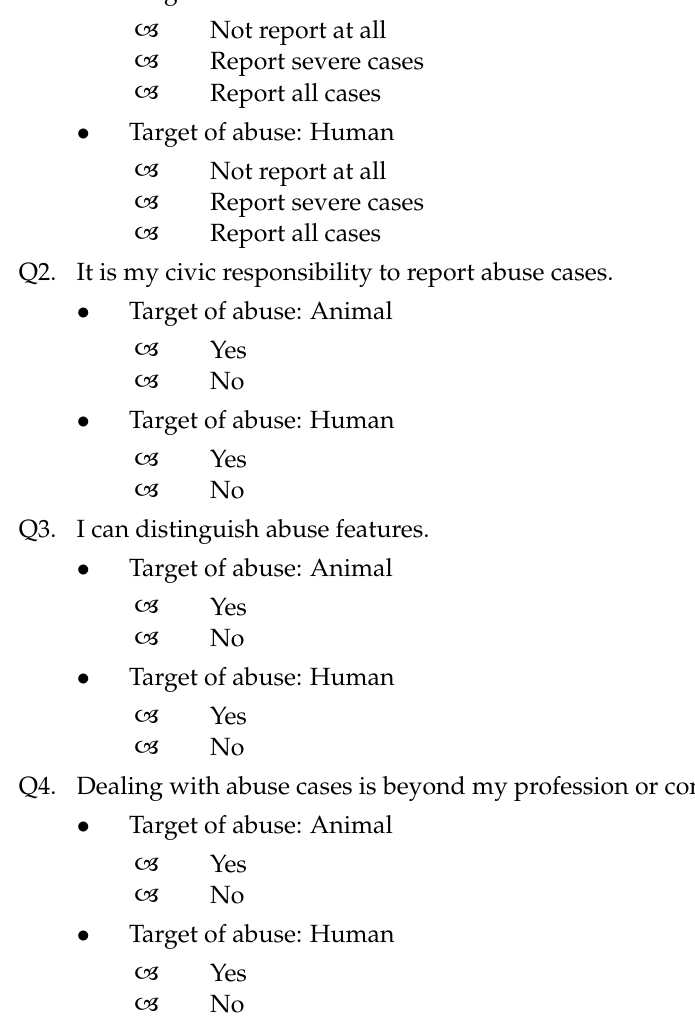
Section 4: Physical animal abuse (limited to veterinary practitioners with clinical ex- perience)